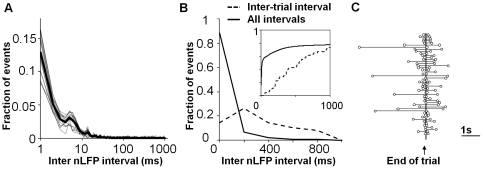
Coherence Potential Cascades Temporally Associated to Trials.(A) Histogram of the time difference between consecutive nLFPs (inter-nLFP interval) within each cluster (grey, thick black: average of all clusters) shows fast cascades with propagation times largely within 10 ms. (B) Distributions of the intervals between the last nLFP of one trial and the first nLFP of the next trial of a trial spanning cluster (RH1, dotted line) were significantly longer than the inter-nLFP intervals within the trials (solid line) indicating clusters are fast trial associated cascades punctuated by longer pauses at the end of the trial. (Inset: cumulative histogram) (Other tasks shown in Figure S2). (C) The pause between trials shown for all 50 trials for trial spanning cluster RH1. Each row represents a trial with the horizontal axis being time. The circles represent last nLFP before the end of the trial and the 1st nLFP at the beginning of a new trial.